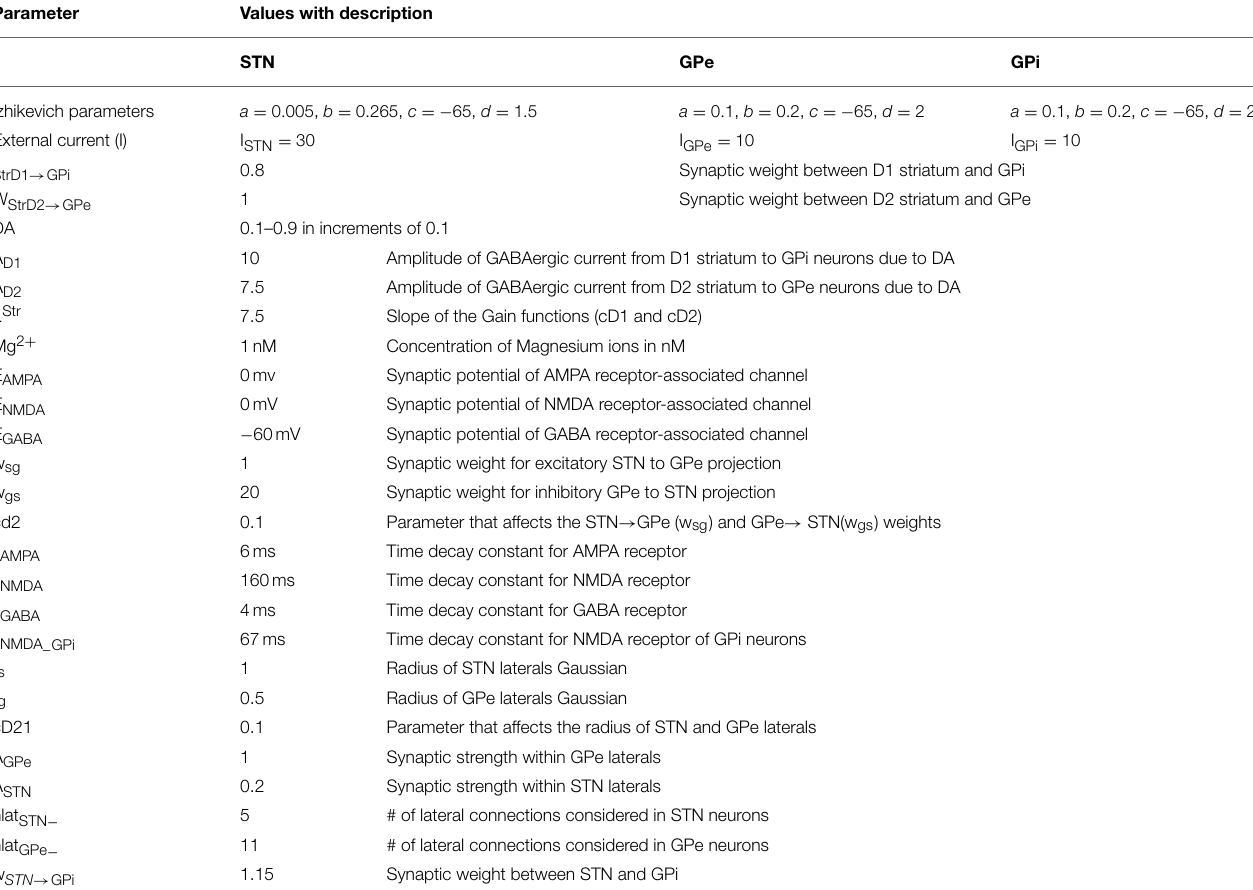
TABLE 1 | Gives the values and the description of the parameters used in the model and simulation. Parameter Values with description STN GPe